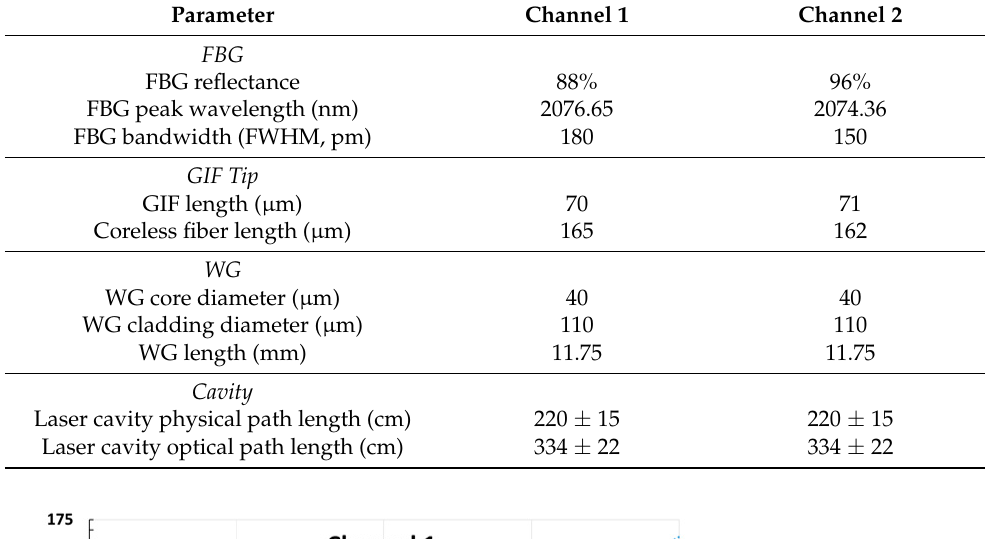
Table 1. Physical parameters associated with each laser channel.